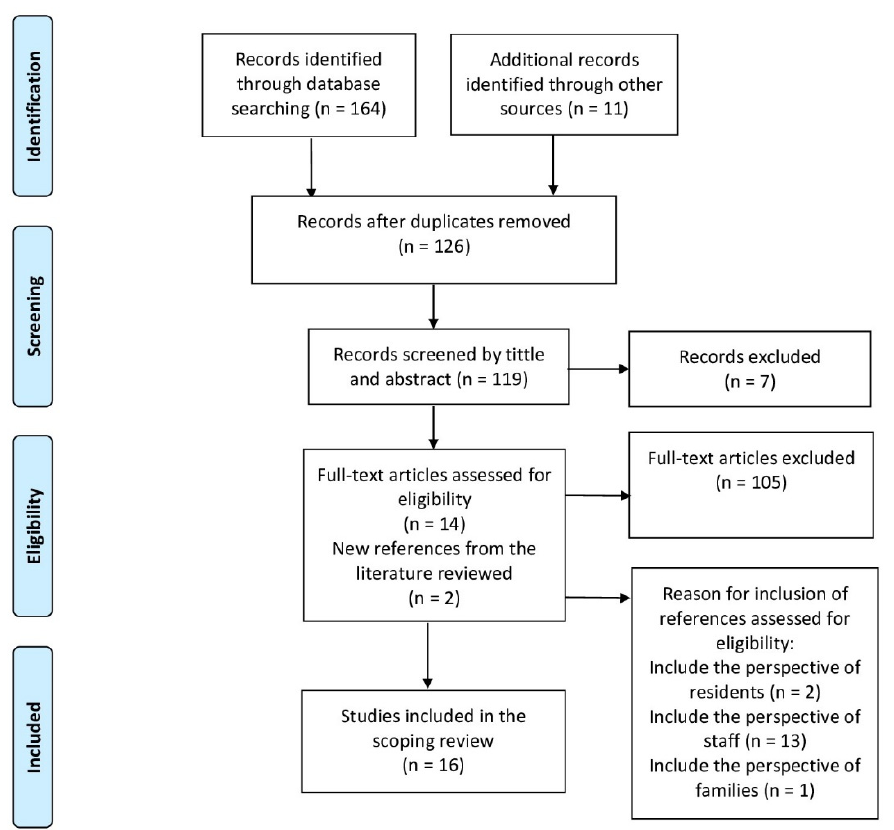
Figure 2. Flow diagram for the scoping review process.